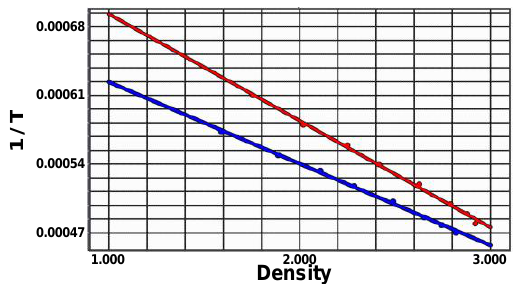
Fig. 5. Calibration data between the density and